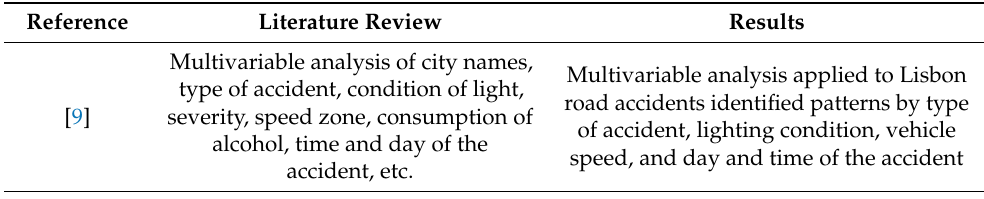
Table 15. Literature review and results